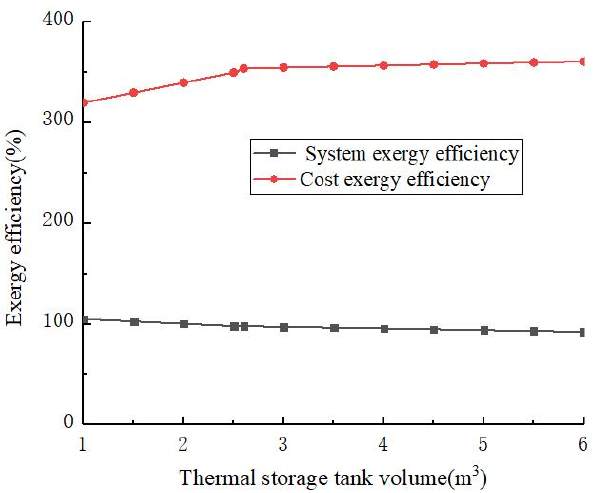
Figure 8. The exergy efficiency changes with the volume of phase-change heat-storage tank.